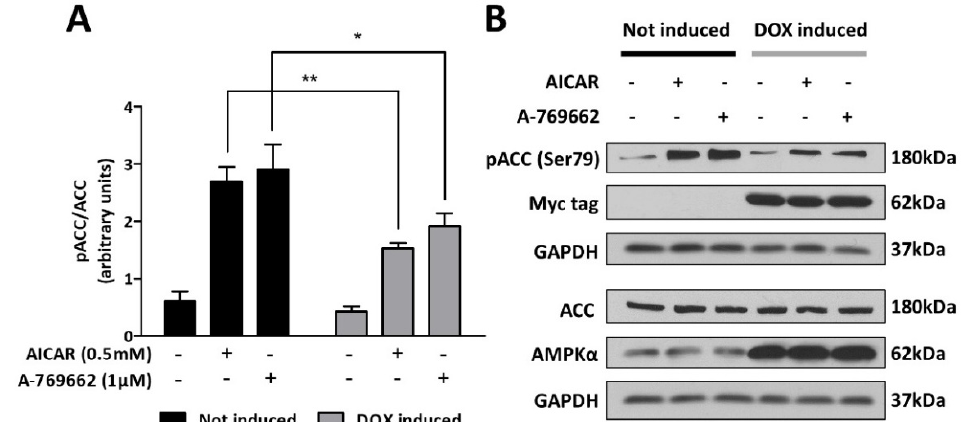
Figure 3. Silencing efficacy of the dominant negative mutant of AMPK α 1 . C6-rtTA-AMPK-DN cells, induced or not with DOX (2 µ g/mL; 24 h), were exposed to the pharmacological AMPK activators AICAR (0.5 mM) and A-769662 (1 µ M) for 3 h. AMPK activity was assessed by immunoblot analysis of the phosphorylation of its downstream target ACC. Phosphorylated ACC and total ACC were immunoblotted on separate gels, and their expression level was normalized to GAPDH. ( A ) Histograms show means ± SEM. ( B ) Blots shown are representative of six independent experiments. Statistical analyses were performed by two-way ANOVA followed by Bonferroni’s multiple comparison test (* p < 0.05, ** p < 0.01).